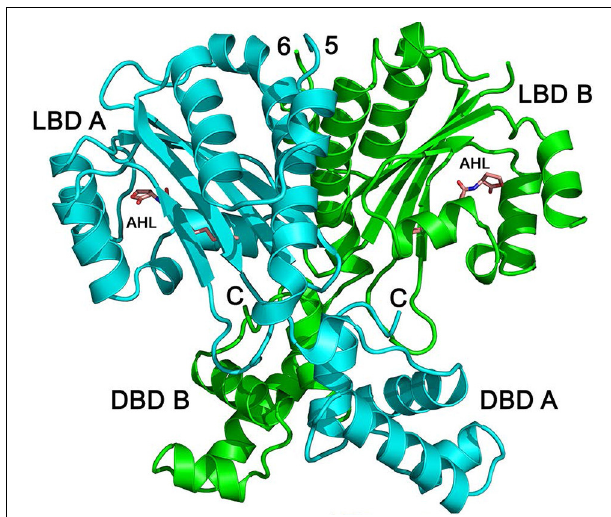
FIGURE 4 | Structure of QscR bound to 3OC12-HSL. The QscR monomers are shown in cyan and green and 3OC12-HSL is shown in orange. The ligand-binding domain (LBD) and the DNA- binding domain (DBD) are also indicated for each chain from Lintz et al. (2011).